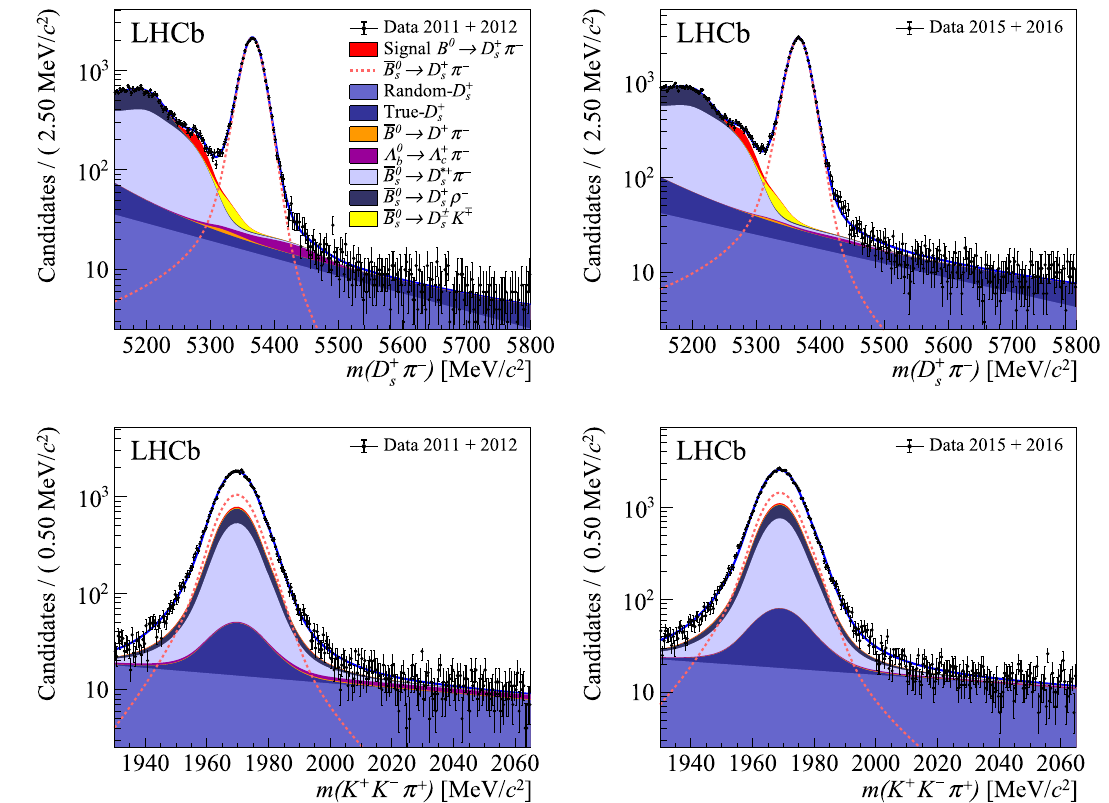
Fig. 3 The (top) D + s π − and (bottom) K + K − π + invariant mass distributions of signal B 0 → D + s π − candidates, for (left) Run 1 and (right) Run 2 data samples. Overlaid are the fit projections along with the signal and background contributions Table 1 Relative systematic uncertainty σ on the B 0 → D + s π −